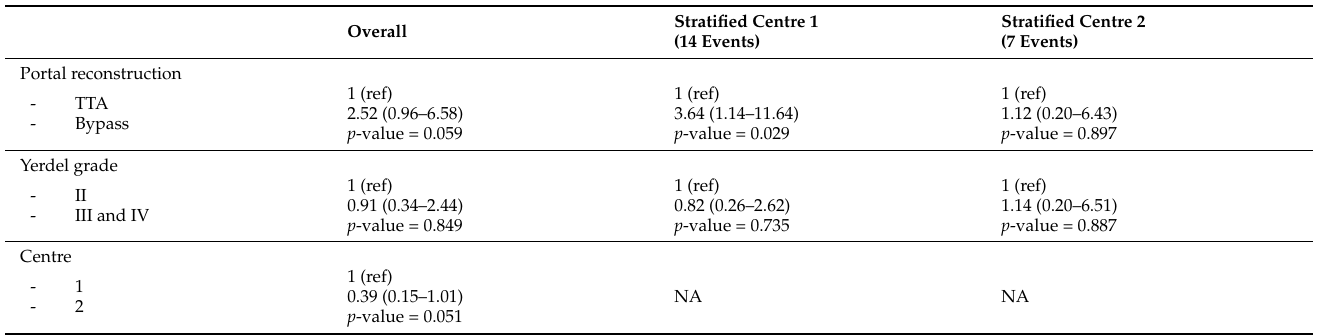
Table 3. Multivariate analysis of correlation between 90-day mortality and the parameters found significant at the univariate analysis and clinically relevant.